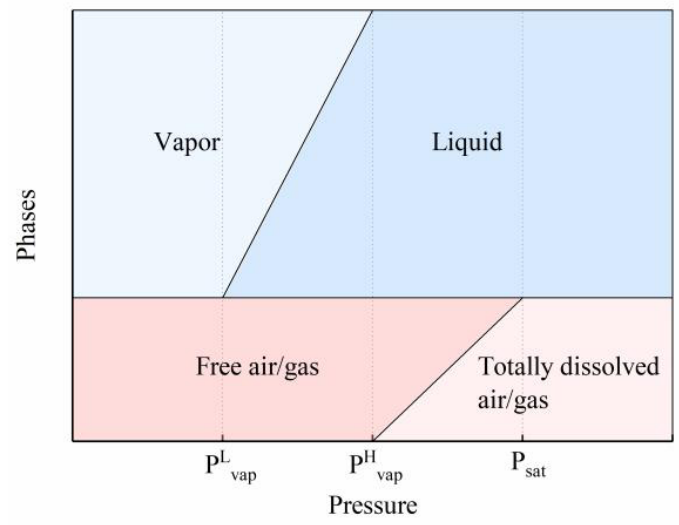
Figure 5. Model of fluid characteristic.